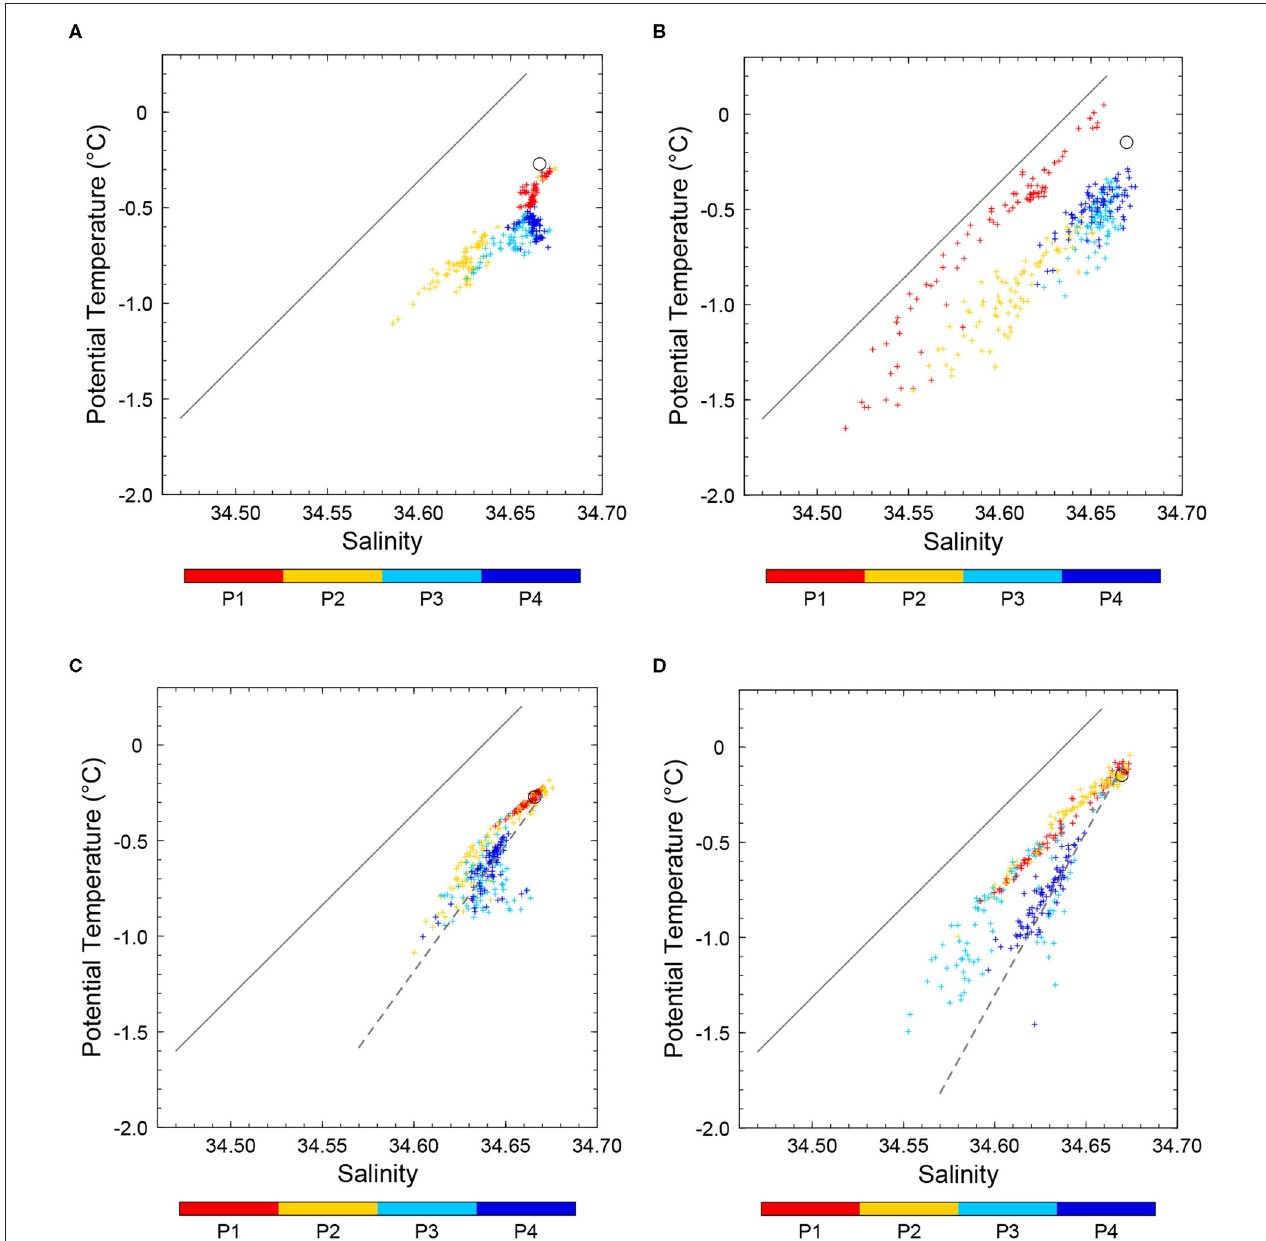
FIGURE 8 | θ - S diagrams for the deepest CT sensors at mooring (A) M1, (B) M2, (C) M3, and (D) M4. The red, orange, light blue, and blue pluses indicate salinity and potential temperature in periods P1, P2, P3, and P4, respectively. The gray lines indicate the mean slope of the mixing line in periods P1 and P2. The gray dashed lines in (C,D) indicate the mixing line in period P4 at moorings M3 and M4, respectively. The circles indicate the point, ( S , θ ) = ( S Ab , θ Ab ), which is used in the Results Section. The details are discussed in the